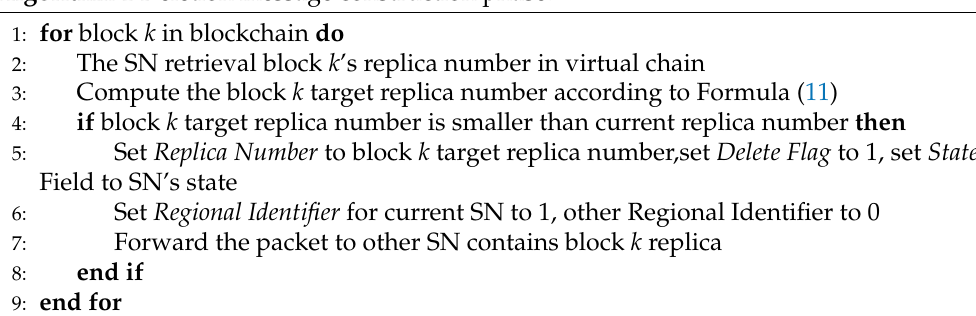
Algorithm 1 Deletion message construction